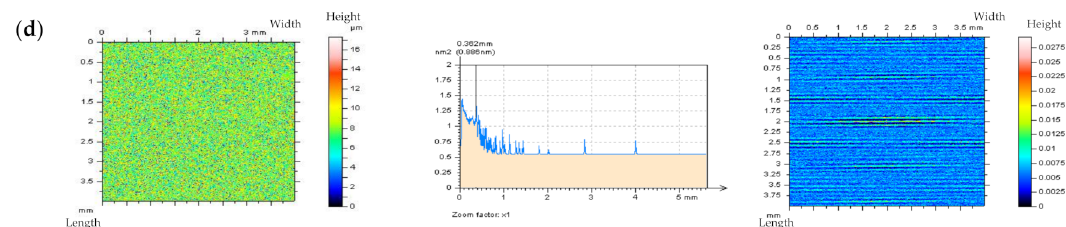
Figure 11. NSs, their PSDs, and threshold ACFs, respectively, described for the laser liner textured surface measured with an optical instrument, defined by: ( a ) CSSF, ( b ) OPGF, ( c ) OPSF, and ( d ) CSOF method; cut–off = 0.025 mm.